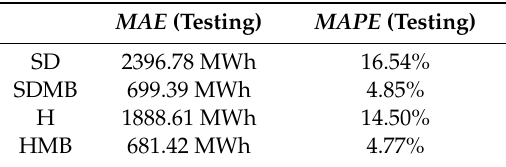
Table 2. Comparison results in terms of mean absolute error ( MAE ) and mean absolute percent error ( MAPE